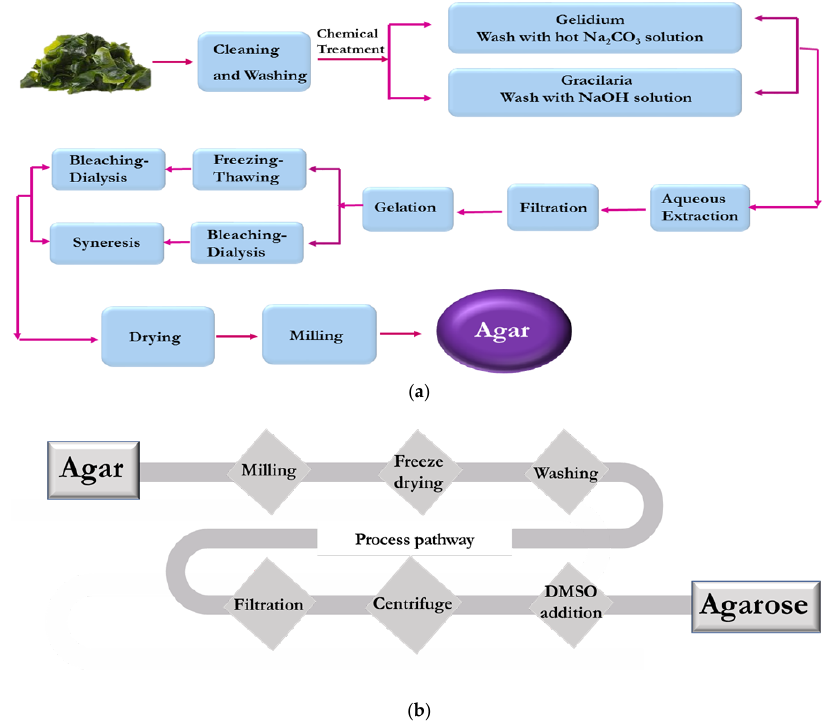
Figure 3. Schematic illustration of extraction route for the production of ( a ) agar from algae through a chemical treatment and physical filtration for ( b ) agarose from agar source using DMSO solution.